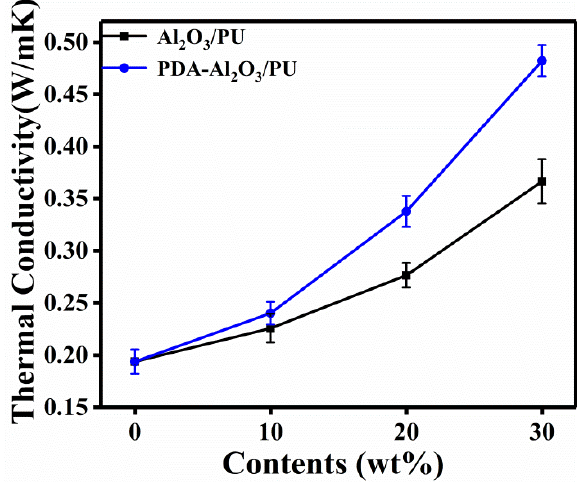
Figure 9. Thermal conductivity of Al 2 O 3 /PU and PDA-Al 2 O 3 /PU composites.